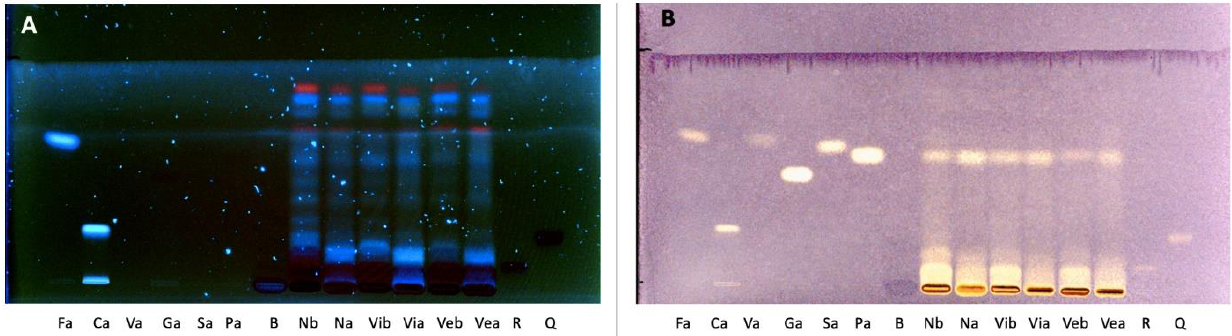
Figure 1. HPTLC plate of standards and samples detected at 366 nm ( A ) and at visible light after derivatization with DPPH ( B ). Fa: Ferulic acid, Ca: Chlorogenic acid, Va: Vanillic acid, Ga: Gallic